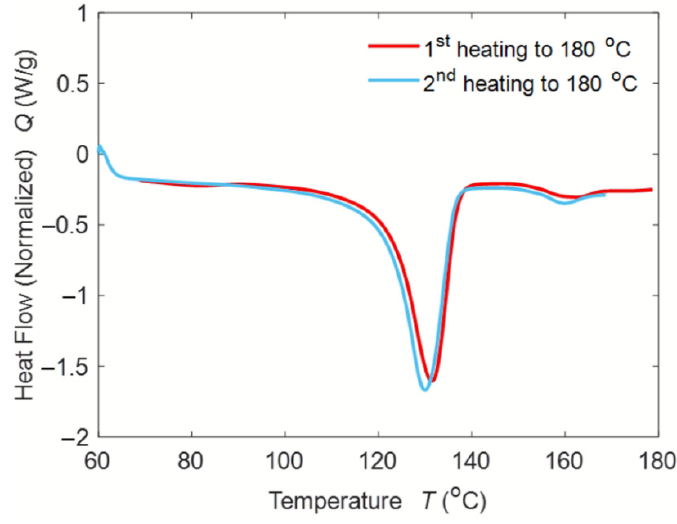
Figure 4. 1st and 2nd heating curves of 30 wt. % PP-Lignin blends. Table 2. DSC Test Results.